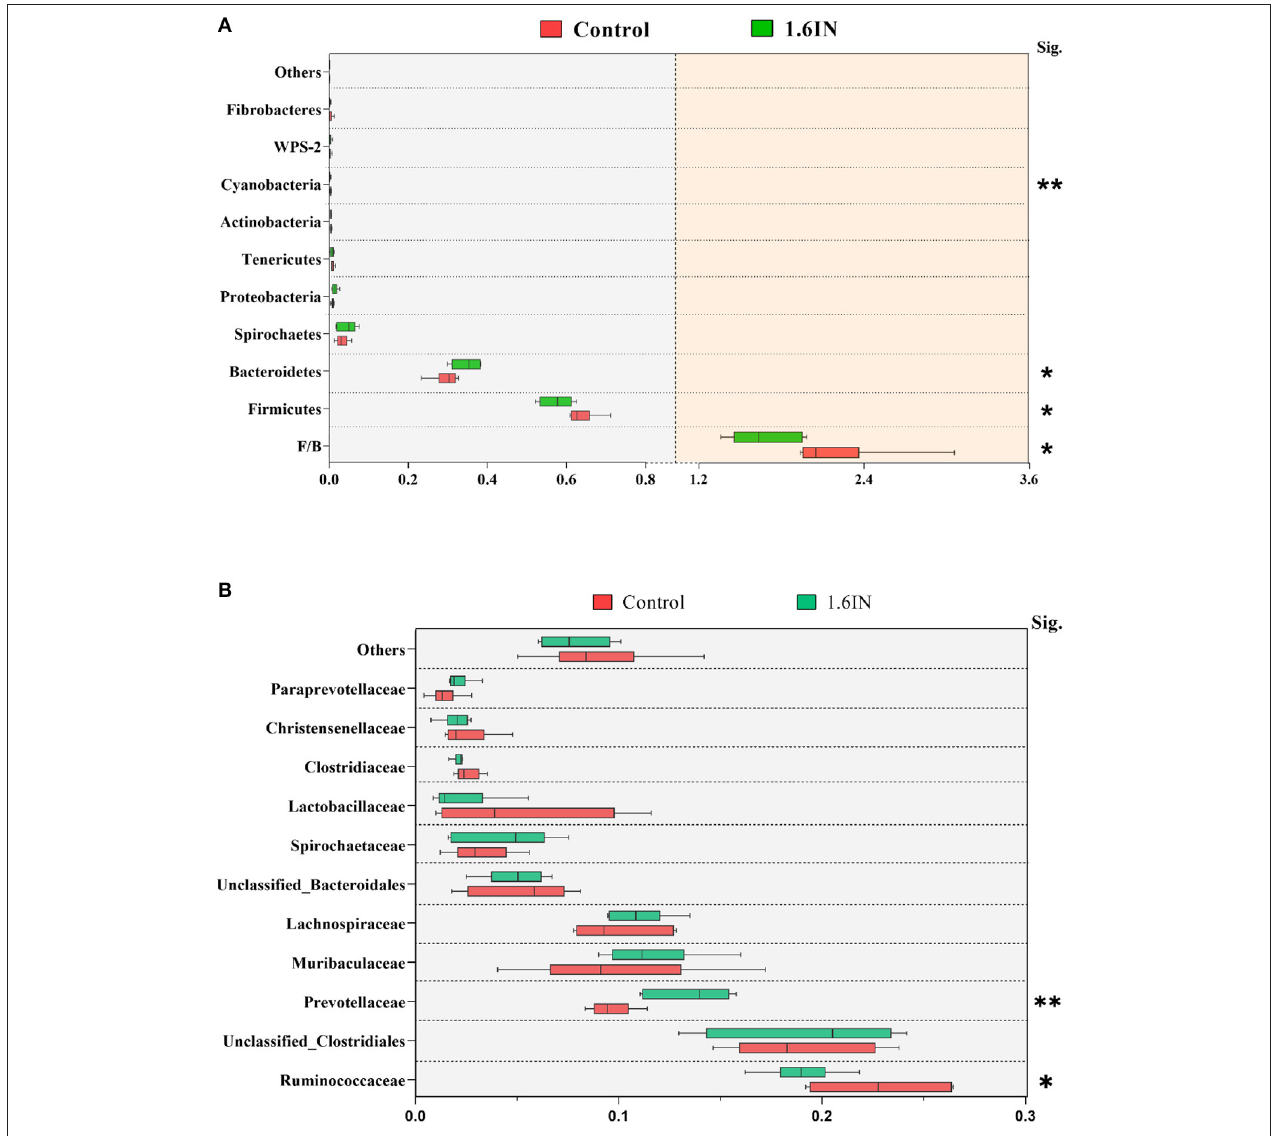
FIGURE 7 | Taxonomy composition of the bacterial communities at (A) the phylum level and (B) the family level (average relative abundance > 0.001 at least one group). Significance was analyzed by an unpaired t -test. * P < 0.05; ** P < 0.01.